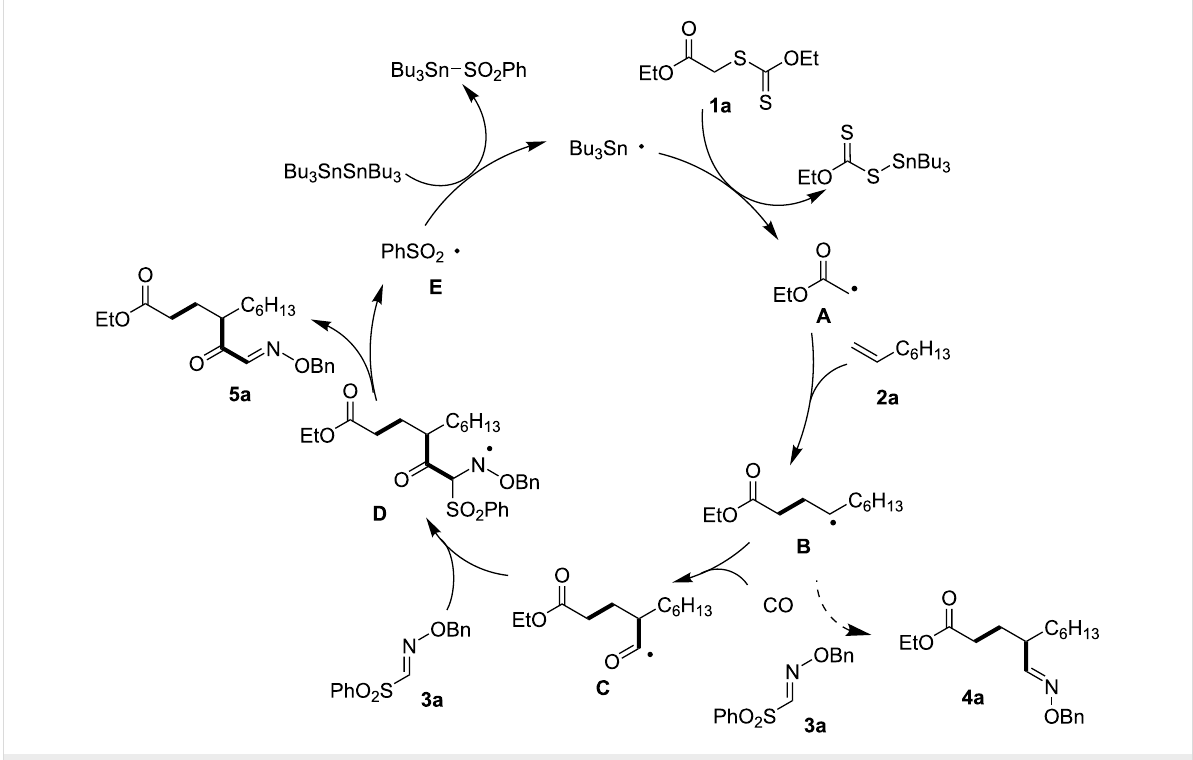
Figure 2: Proposed radical chain